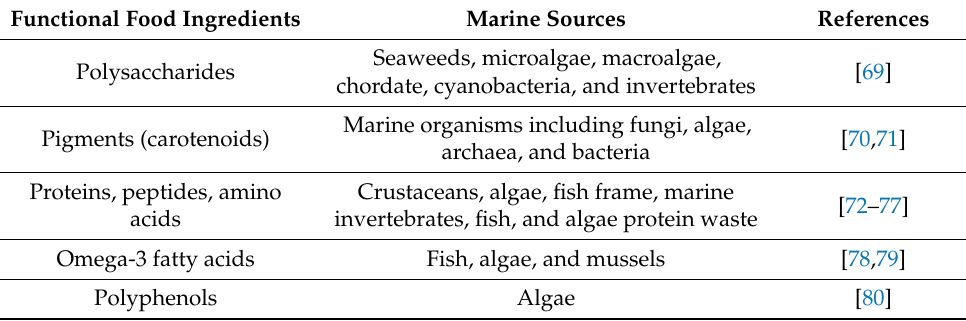
Table 2. Marine-derived functional food ingredients and their marine sources. Functional Food